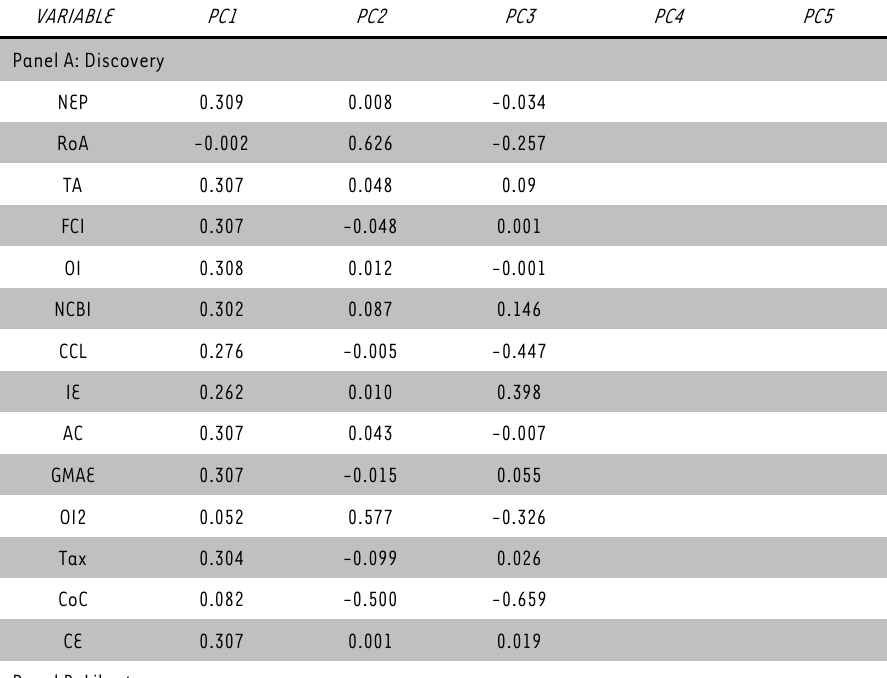
TABLE 5: Eigenvectors for insurance